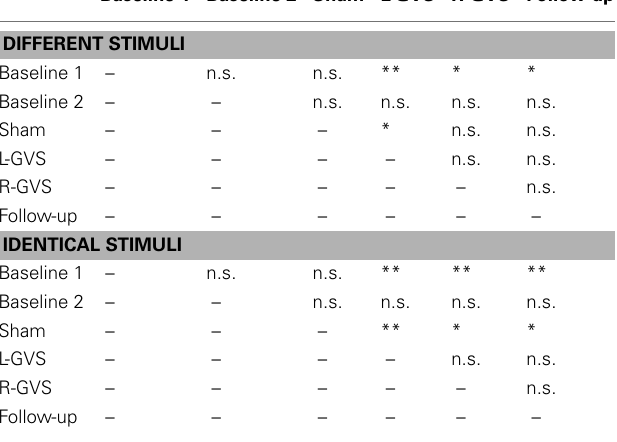
Table 3 | Summary of paired comparisons between the different GVS conditions for the left hand of the GVS group, separately for different and identical tactile